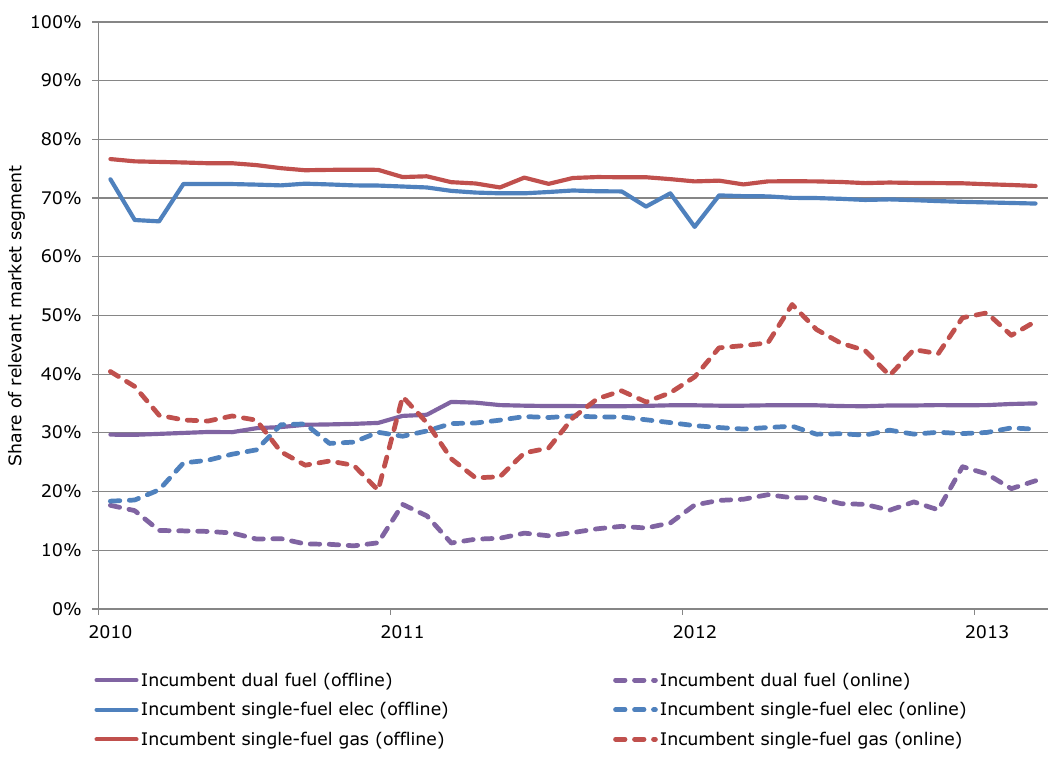
Figure 20: Incumbents’ shares of online customers versus offline customers (in their ‘home’ regions)